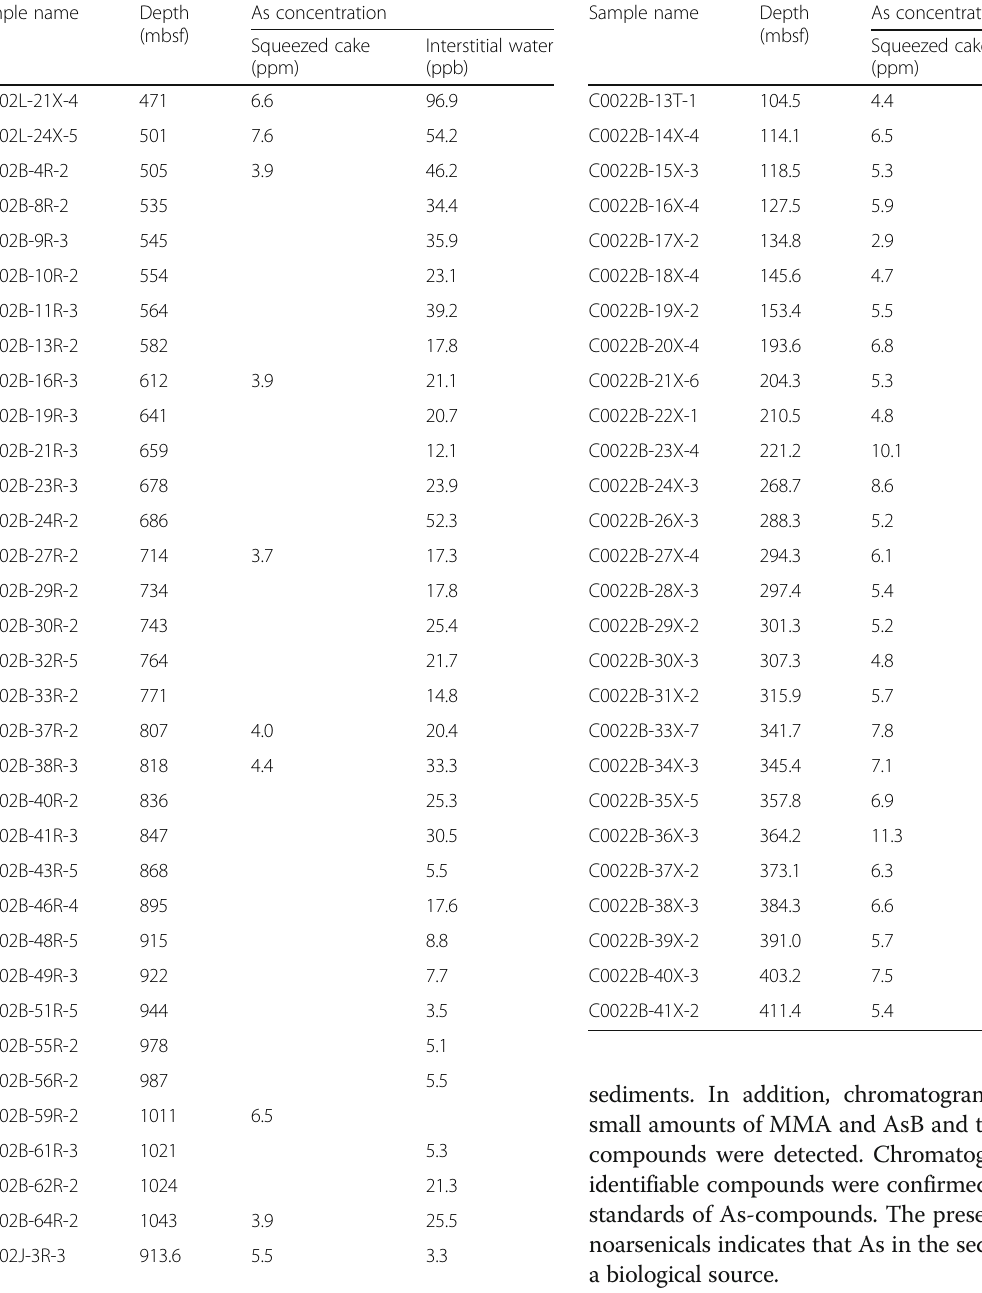
Table 1 Total arsenic concentration of squeezed cake and interstitial water of sediments from the Sites C0002, C0021